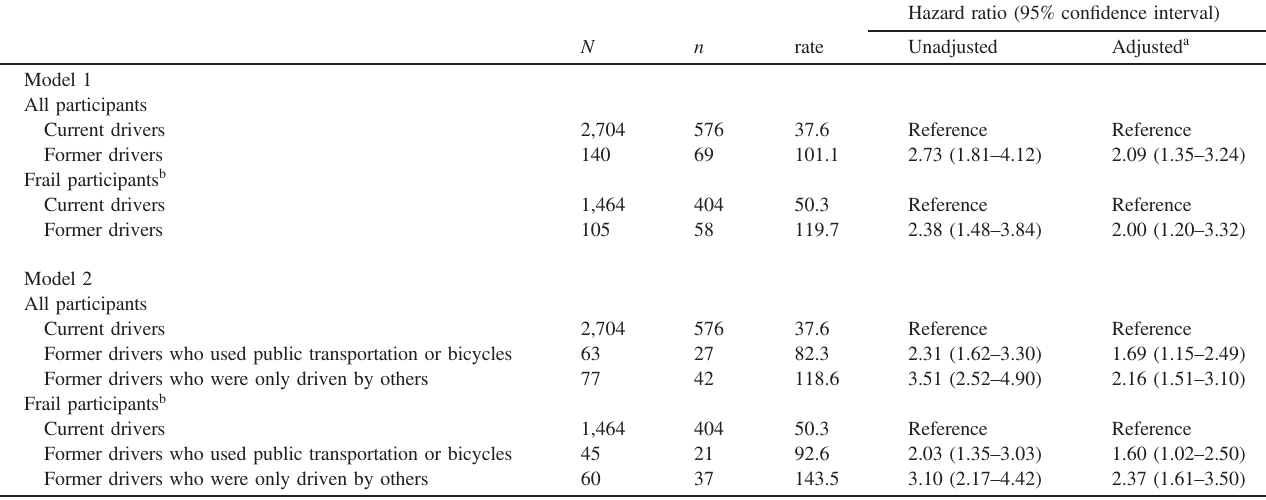
Table 3. The risk of functional limitations among current drivers and former drivers (who used public transportation or bicycles, and who were only driven by others) over a 6-year period from August 2010 to November